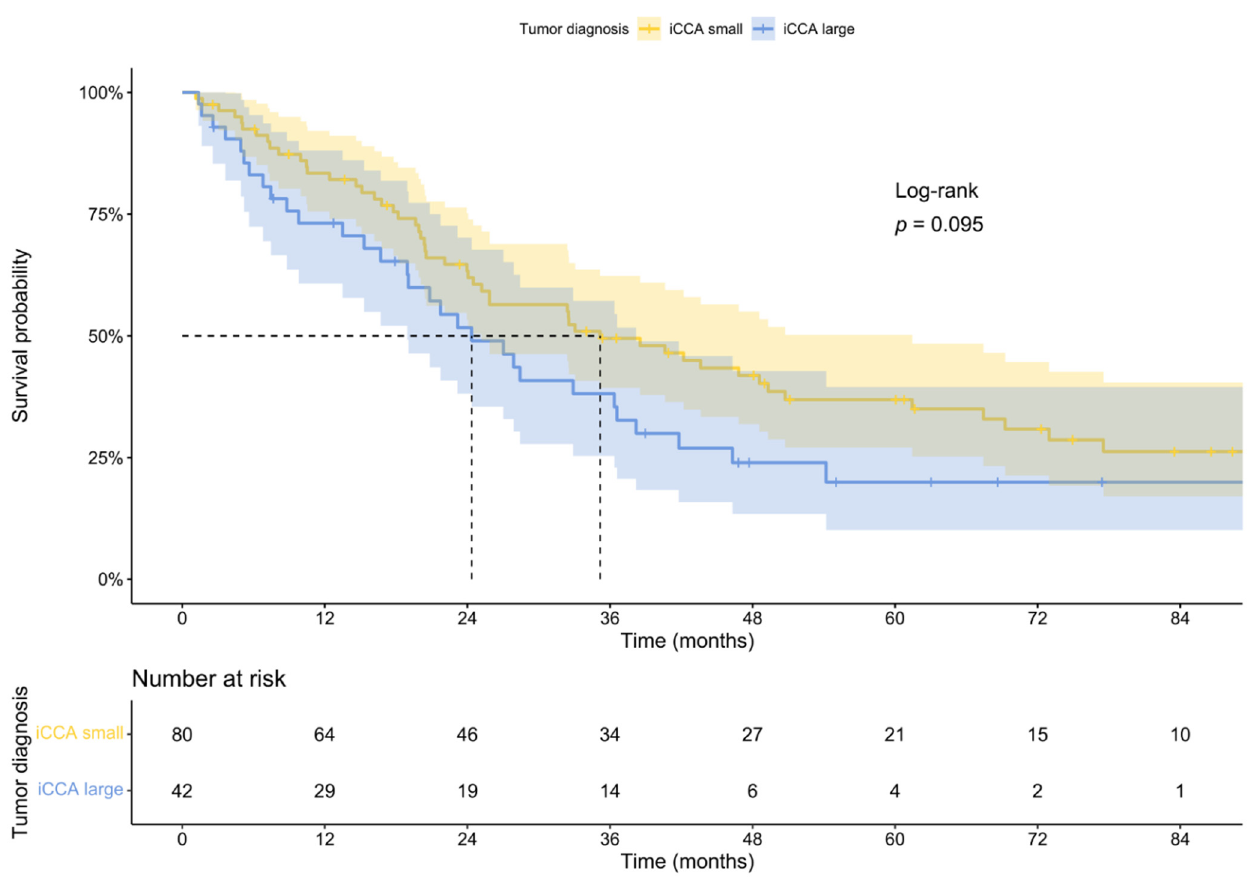
Figure 3. Overall survival of patients according to different iCCA subtypes.